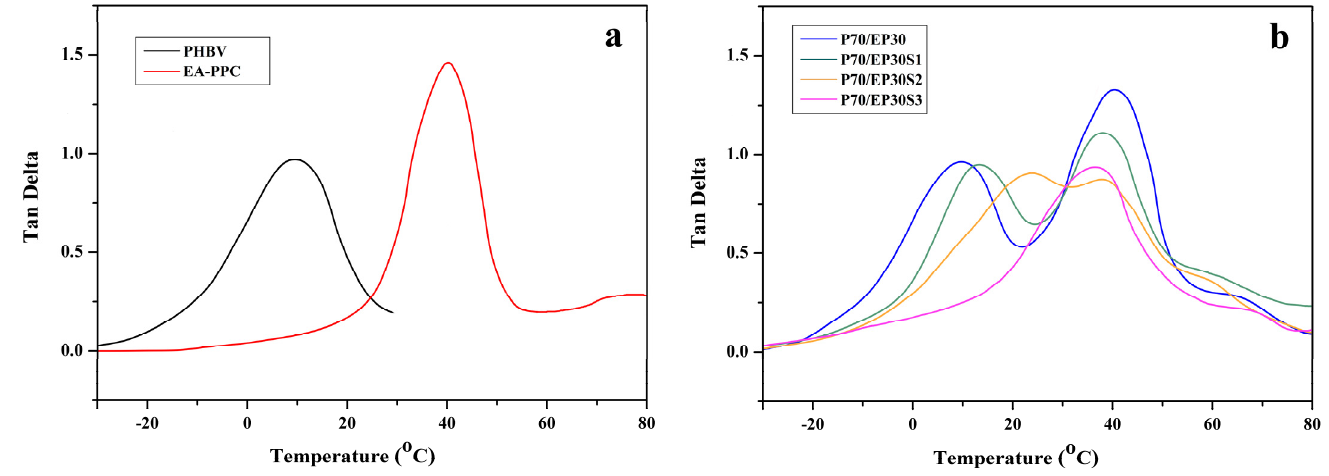
Figure 4. DMA of neat polymers ( a ) and PHBV/EA–PPC blends ( b ).